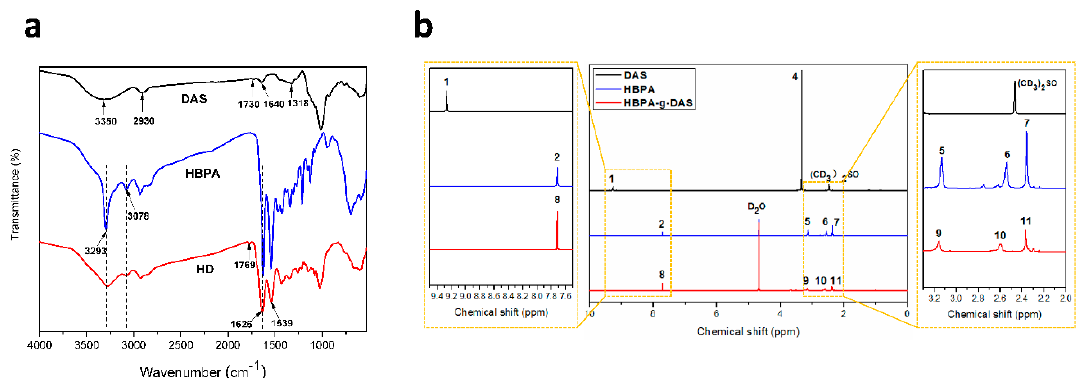
Figure 1. ( a ) FTIR and ( b ) 1 H NMR spectra of dialdehyde starch (DAS), hyper-branched polyamide (HBPA), and hyper-branched aminated starch (HD).